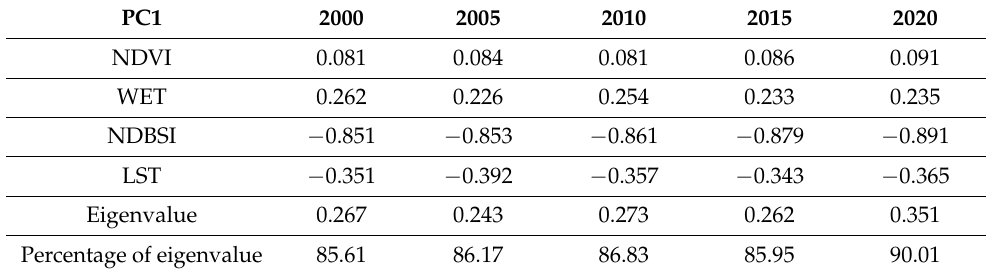
Table 1. First Principal Component (PC1) of Principal Component Analysis for the RSEI in 2000,